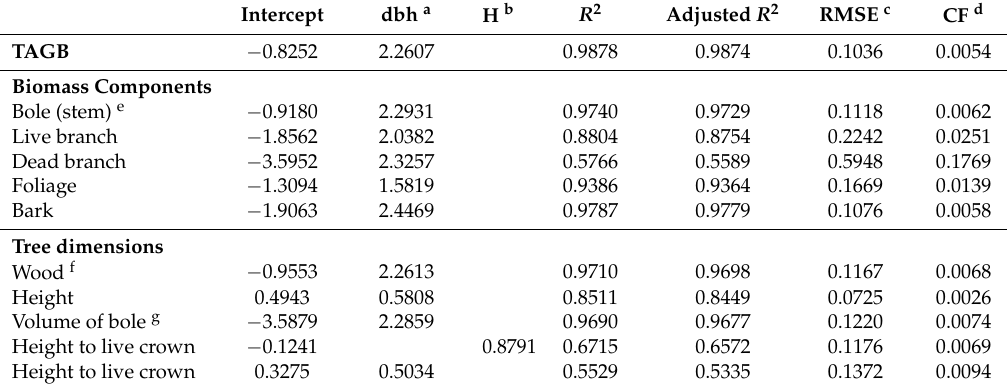
Table 4. Localized allometric regression models developed to predict biomass and other tree components for coast redwood ( Sequoia sempervirens ) from industrial timberlands. All components were expressed in oven dry kilograms (ODKg); except for total height (H) and height to live crown (m) and volume of bole (m 3 ). The number of observations for all components was 26, except for total aboveground biomass (TAGB) and foliage ( n = 29). All models and their parameters were significant at p < 0.001.